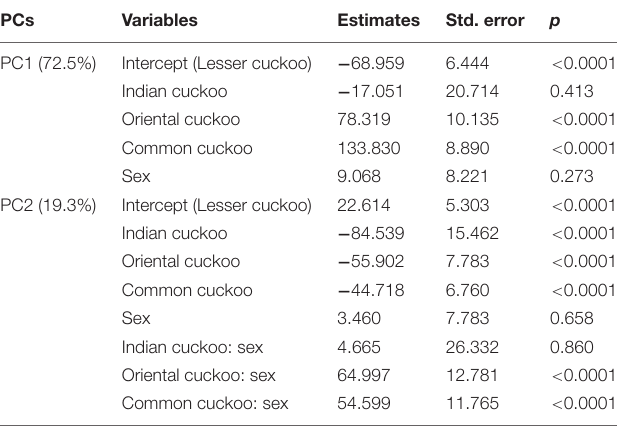
TABLE 5 | Results of the linear models for PC1 and PC2 extracted from 11 morphological traits of the four Cuculus